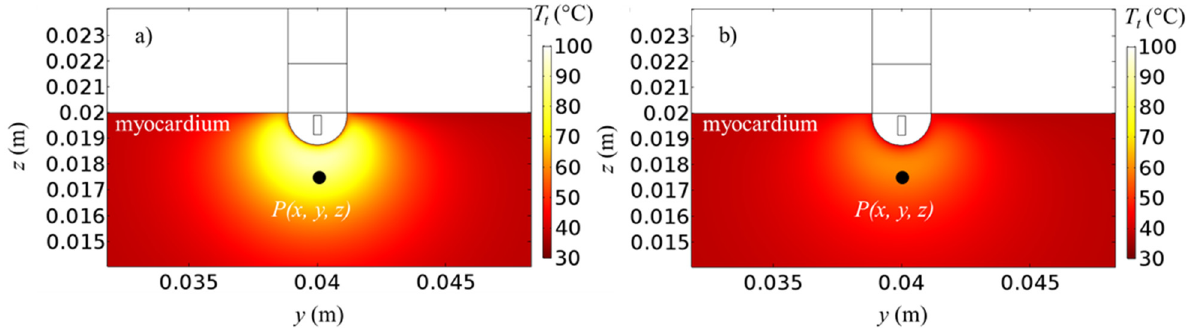
Figure 3. Tissue temperature fields for | u | in = 0.05 m/s, V 0 = 22.5 V, ( a ) ω * = 1.000 ( t = 30 s) and ( b ) ω * = 0.033 ( t = 60 s).